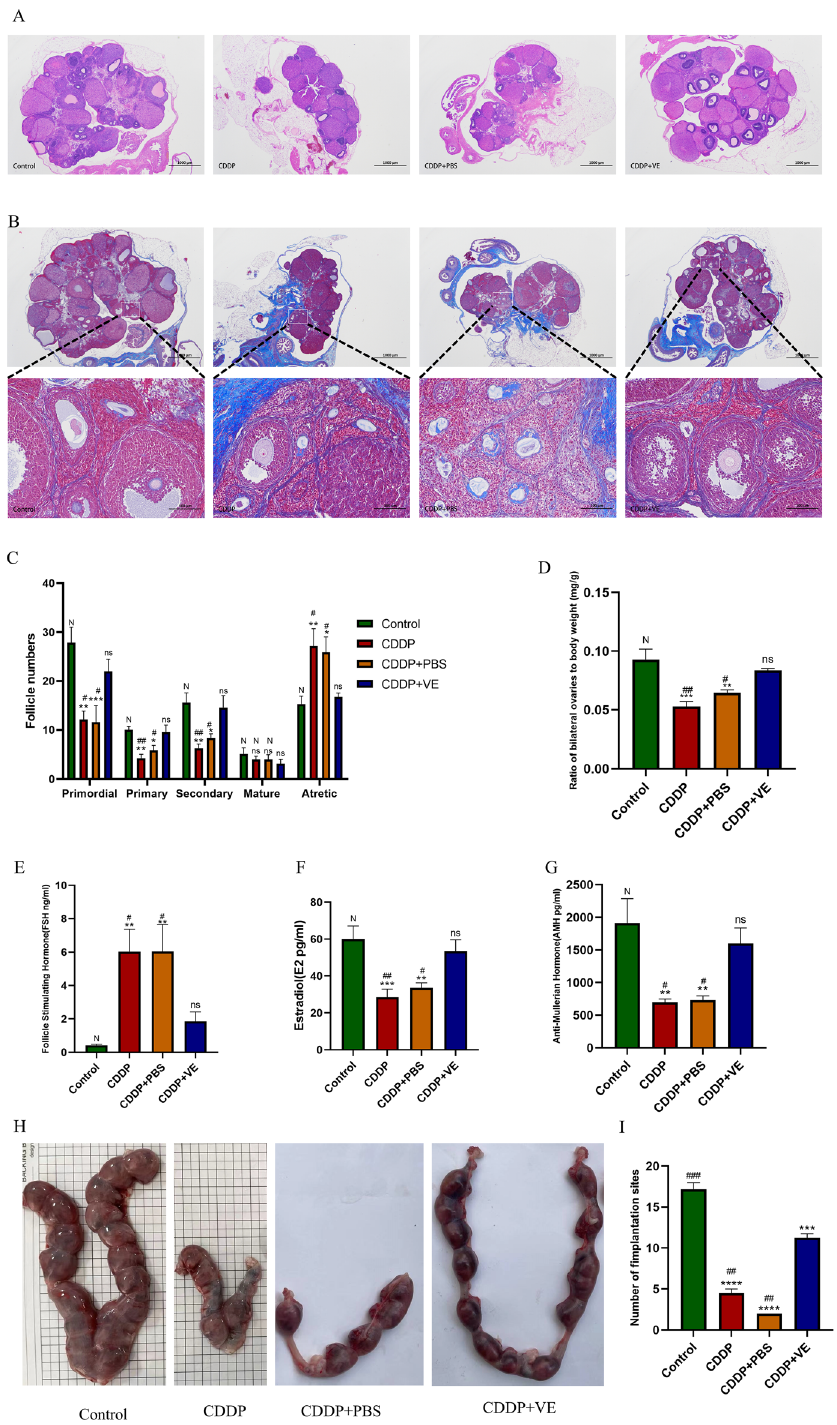
Figure 2. Effects of CDDP and ferroptosis inhibitor Vitamin E on ovarian function and fertility in rats. ( A , C ) HE staining of the ovarian tissue structure in each group and the statistical results of the number of follicles in different developmental stages. ( B , D ) Masson trichrome staining of the ovarian tissue in each group observed under a microscope. ( E , F , G ) Serum FSH, E2 and AMH levels in each group. ( H ) Gross observation of uterine litter size of rats in each group. (I) Summary of embryo numbers at implantation sites of each group. The score of stained Masson trichrome Staining was quantitated using ImageJ software. Data are expressed as the means ± SEM. ns, * versus control, * P < 0.05, ** P < 0.01, *** P < 0.001 and **** P < 0.0001, ns indicates no statistical significance. N, # versus CDDP + VE, # P < 0.05, ## P < 0.01, ### P < 0.001 and #### P < 0.0001, N indicates no statistical